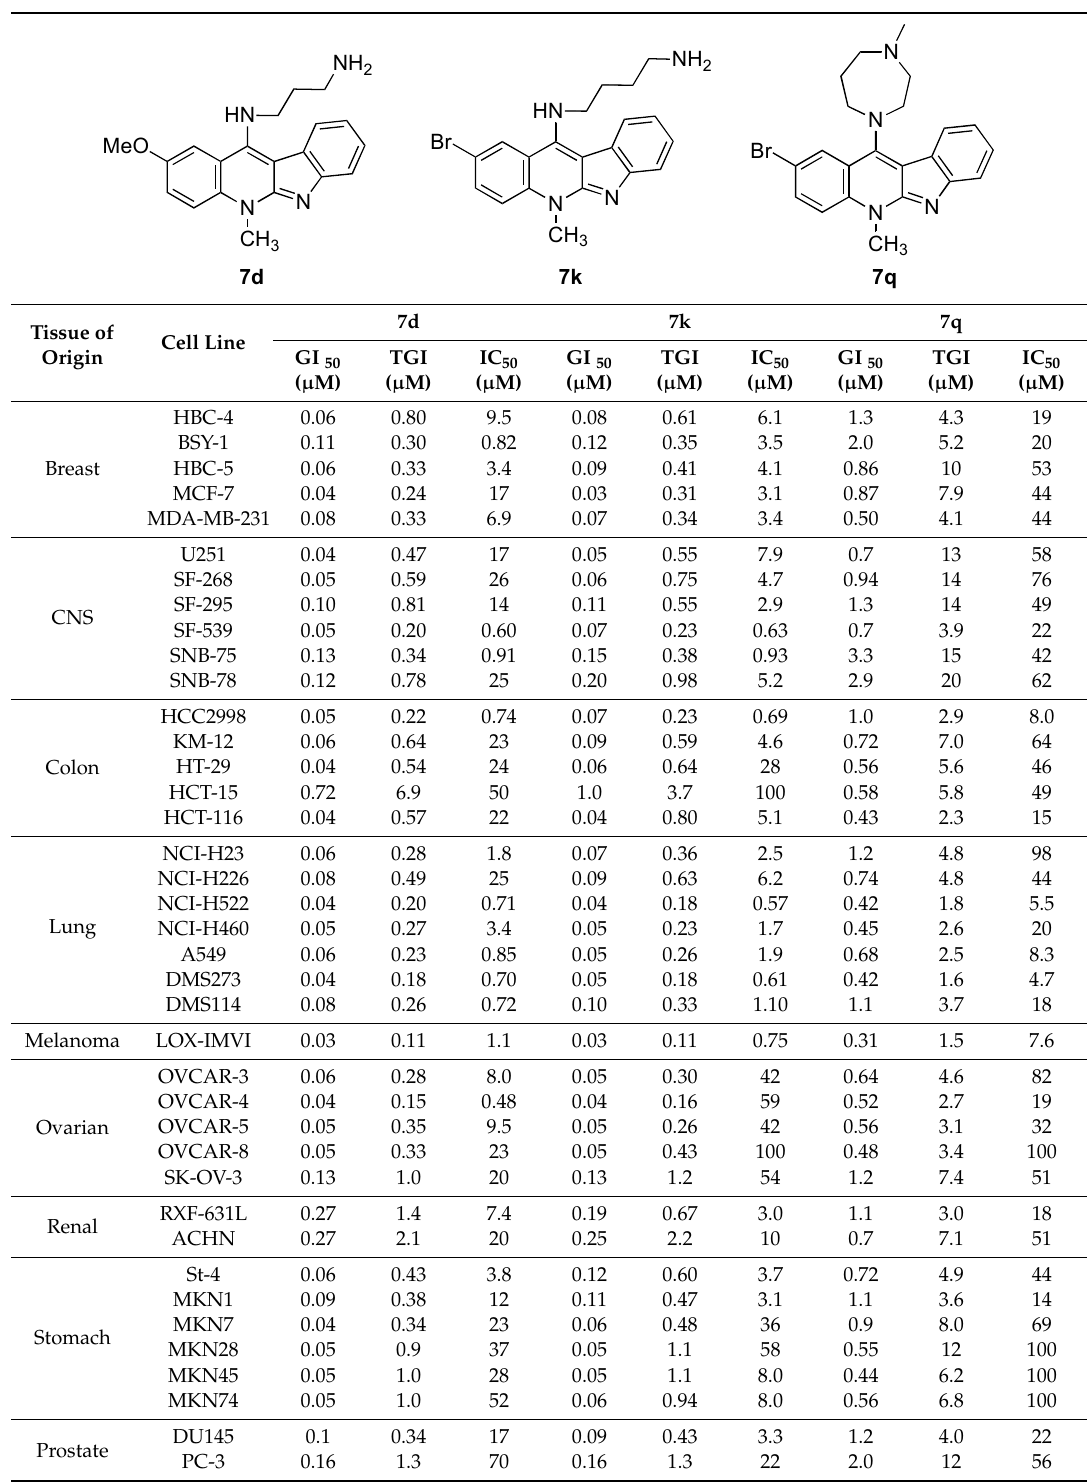
Table 5. Growth inhibitory (GI 50 ) and cytotoxic (LC 50 ) activities of compounds 7d , 7k and 7q across the JFCR 39 panel.